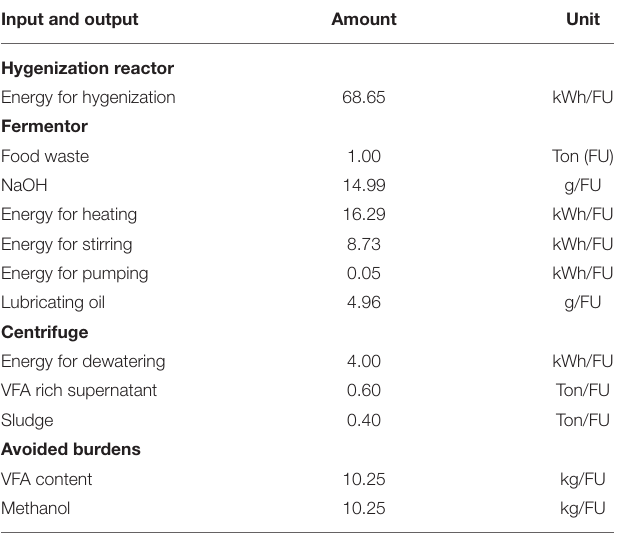
TABLE 3 | Aggregated inventory of the investigated system.